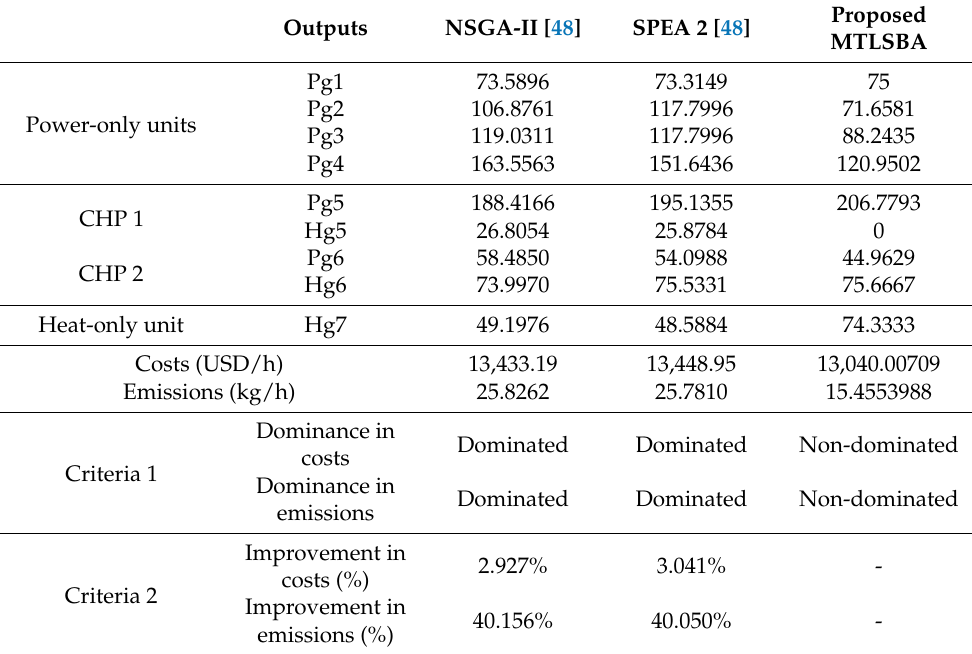
Table 5. Best Compromise results of test system 2 using the proposed MTLSBA.